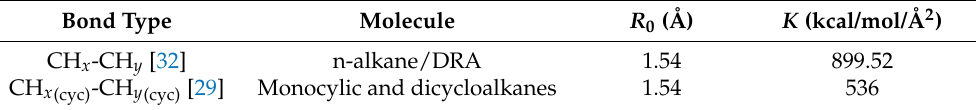
Table 3. Bond stretching parameters for the TraPPE-UA force field.